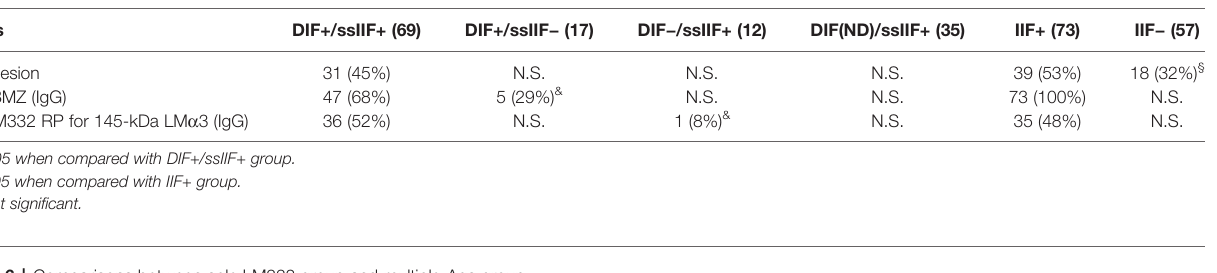
TABLE 6 | Comparisons between sole LM332 group and multiple-Ags group.